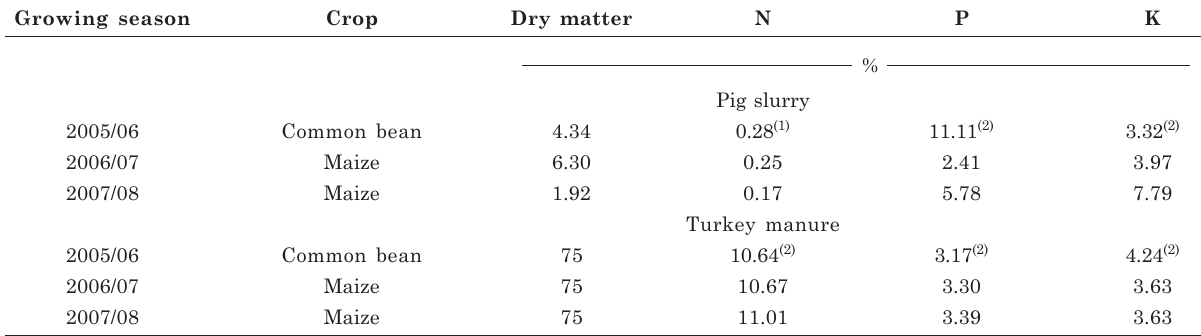
(1) Analysis on a wet base; (2) Analysis on dry Table 2. Nutrient amounts applied with pig slurry and turkey manure in the 2005 to 2008 growing seasons Treatment